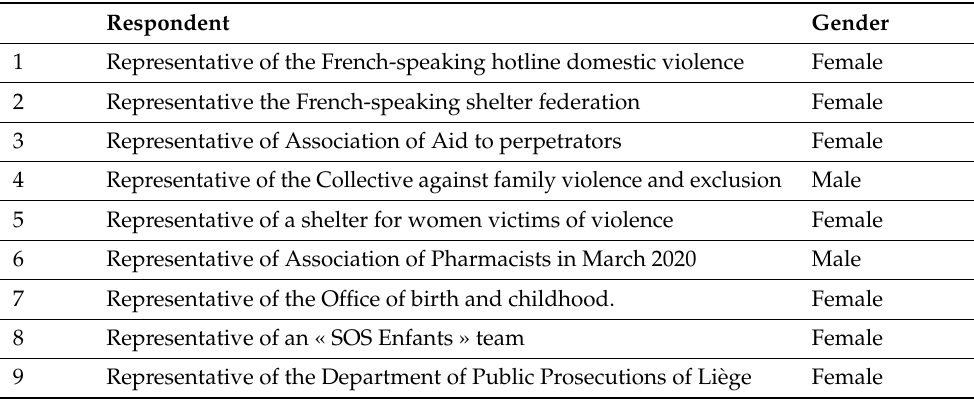
Table 1. Summary table of interviews with civil society.